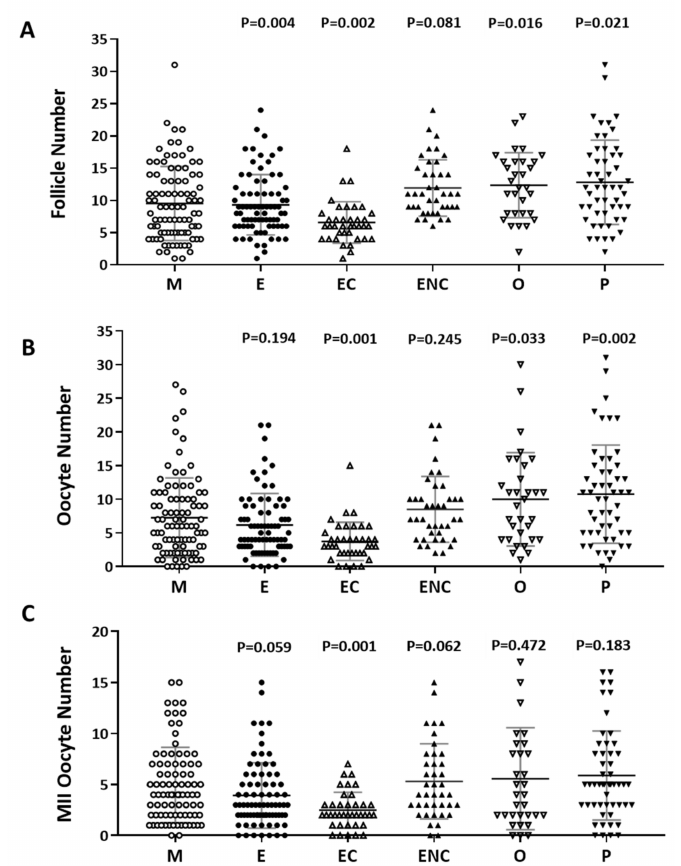
Figure 2. Comparison of oocyte quality and quantity in the di ff erent groups as an indication of infertility. The ( A ) follicle number, ( B ) oocyte number, and ( C ) number of mature oocytes (metaphase II) from all infertility patient groups. The infertile individuals were grouped into six groups: male factor (as control group, M), endometriosis (E), ovarian endometrioma (EC), endometriosis without ovarian endometrioma (ENC), other female factors (O), and polycystic ovary syndrome (P). The p -value for each group versus the male factor group was determined by an unpaired t